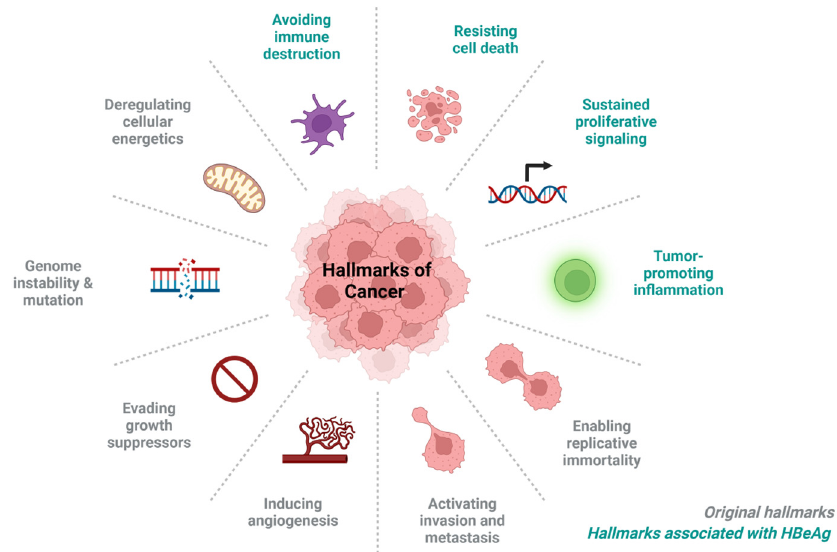
Figure 1. Hallmarks of cancer: HBeAg associated hallmarks of cancer are indicated in blue. Image created using biorender.com.